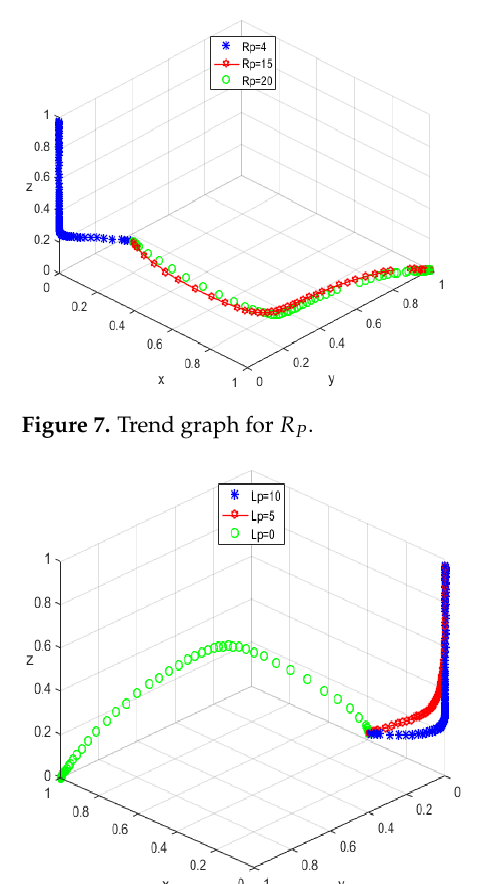
Figure 8. Trend graph for L P